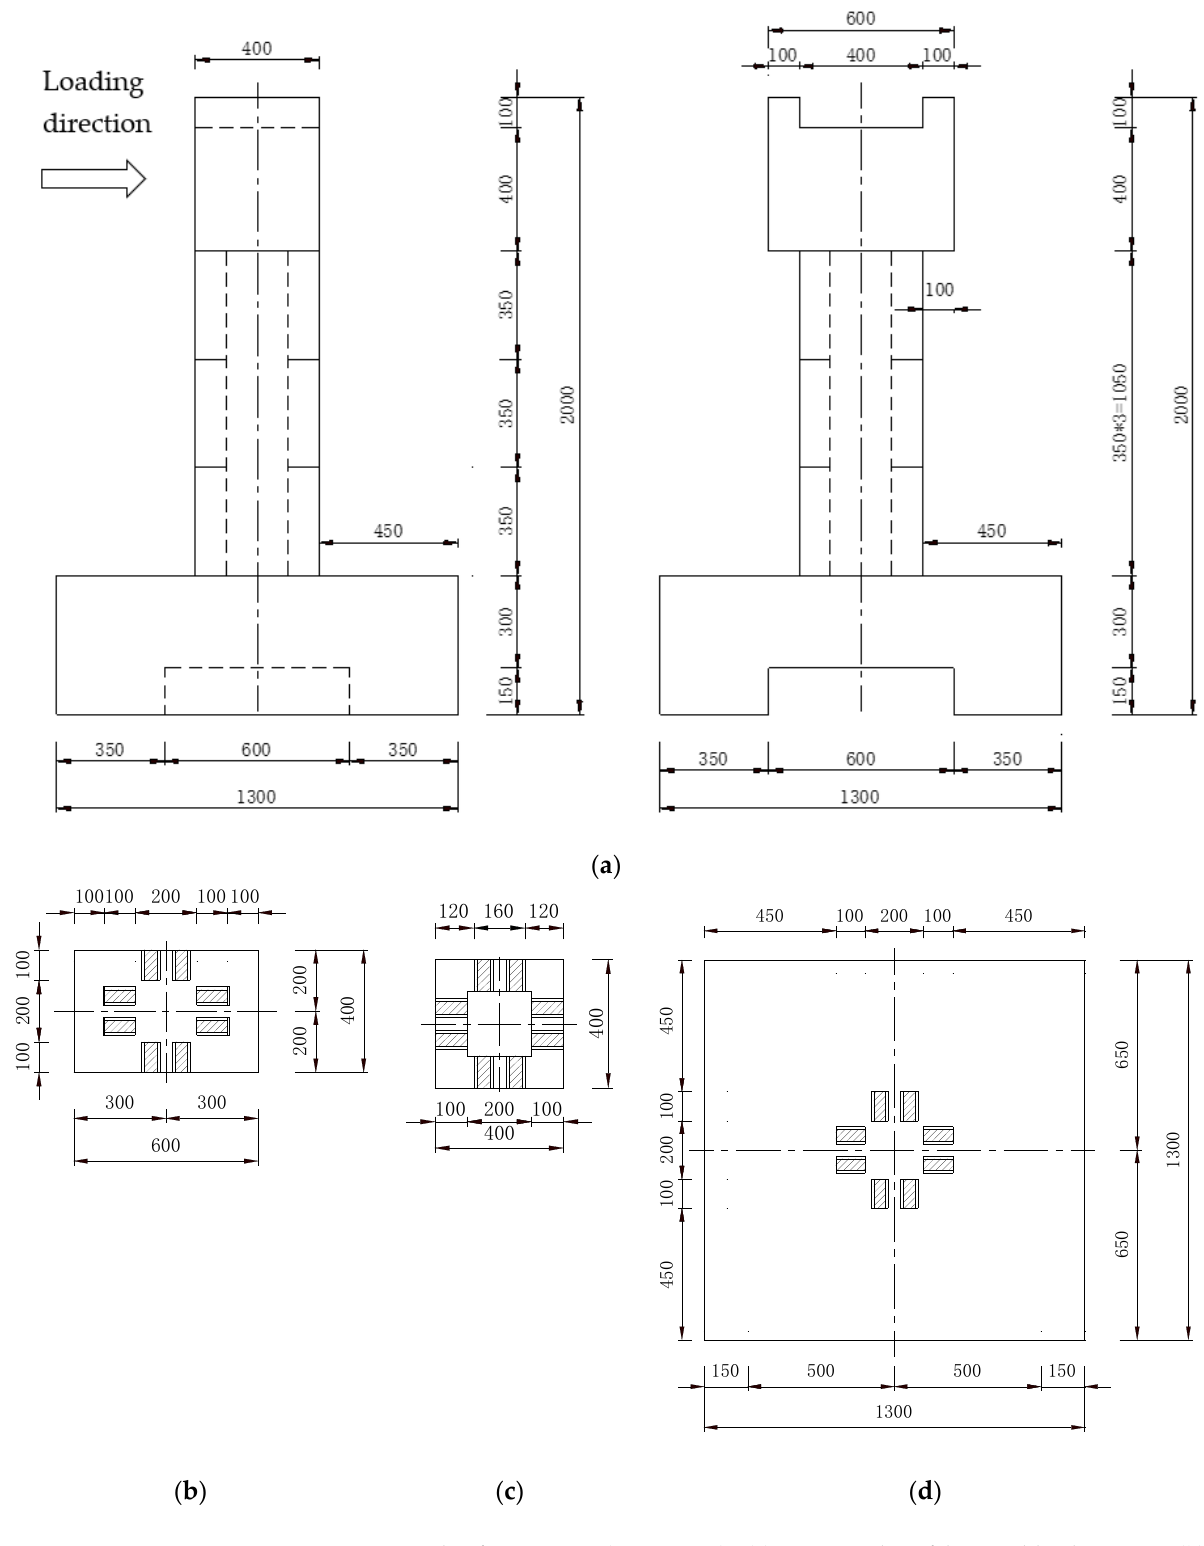
Figure 2. Details of specimens (units: mm). ( a ) Segmental prefabricated bridge piers. ( b ) Load segment. ( c ) Segment. ( d ) Bearing platform.